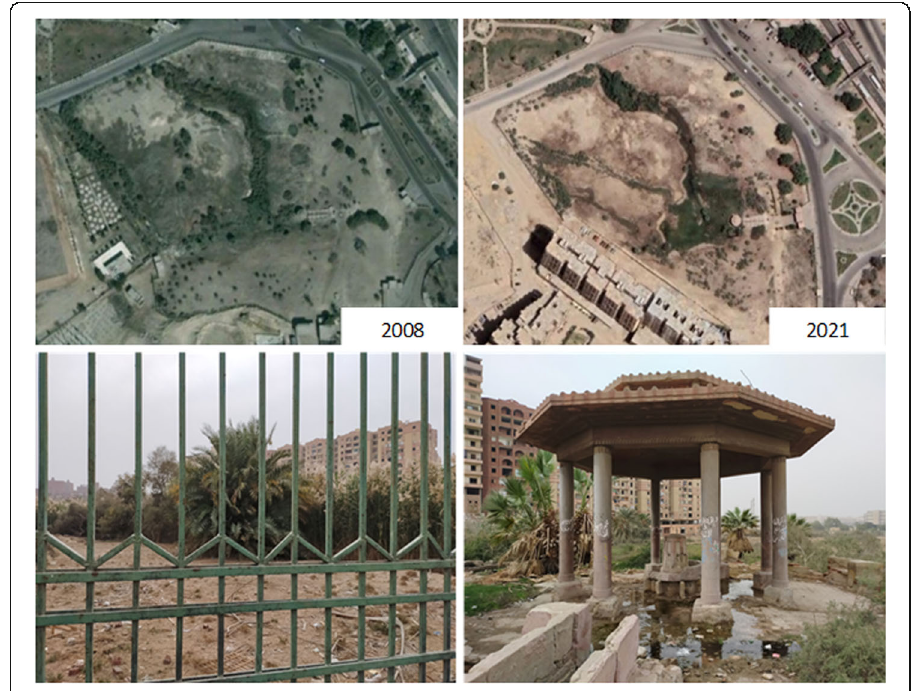
Fig. 13 The closed and deteriorated Ain Helwan Park, Helwan District — Top images Map data © 2021